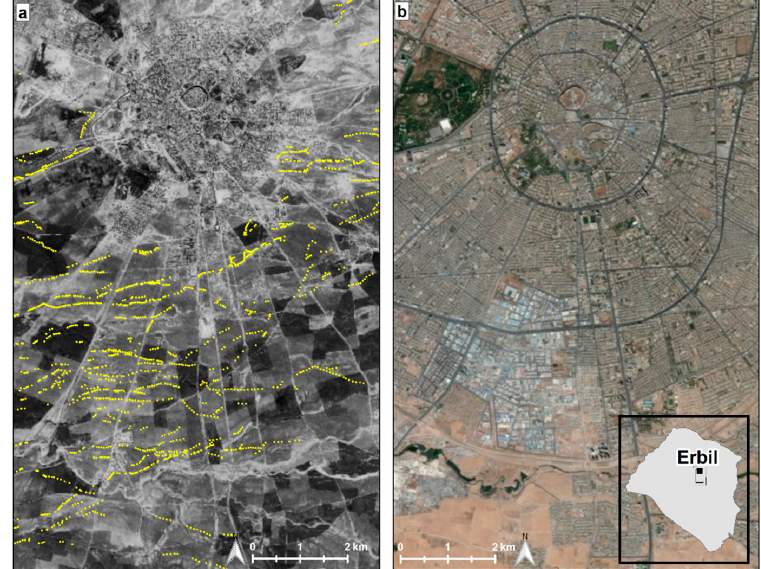
Figure 6. Using historic satellite imagery is necessary in many areas of the world where processes such as development have destroyed the archaeological record of past landscapes. ( a ) qanat shafts (yellow dots) abundant south of Erbil on the 1968 CORONA are ( b ) destroyed by modern development (basemap: ESRI, WorldImagery).